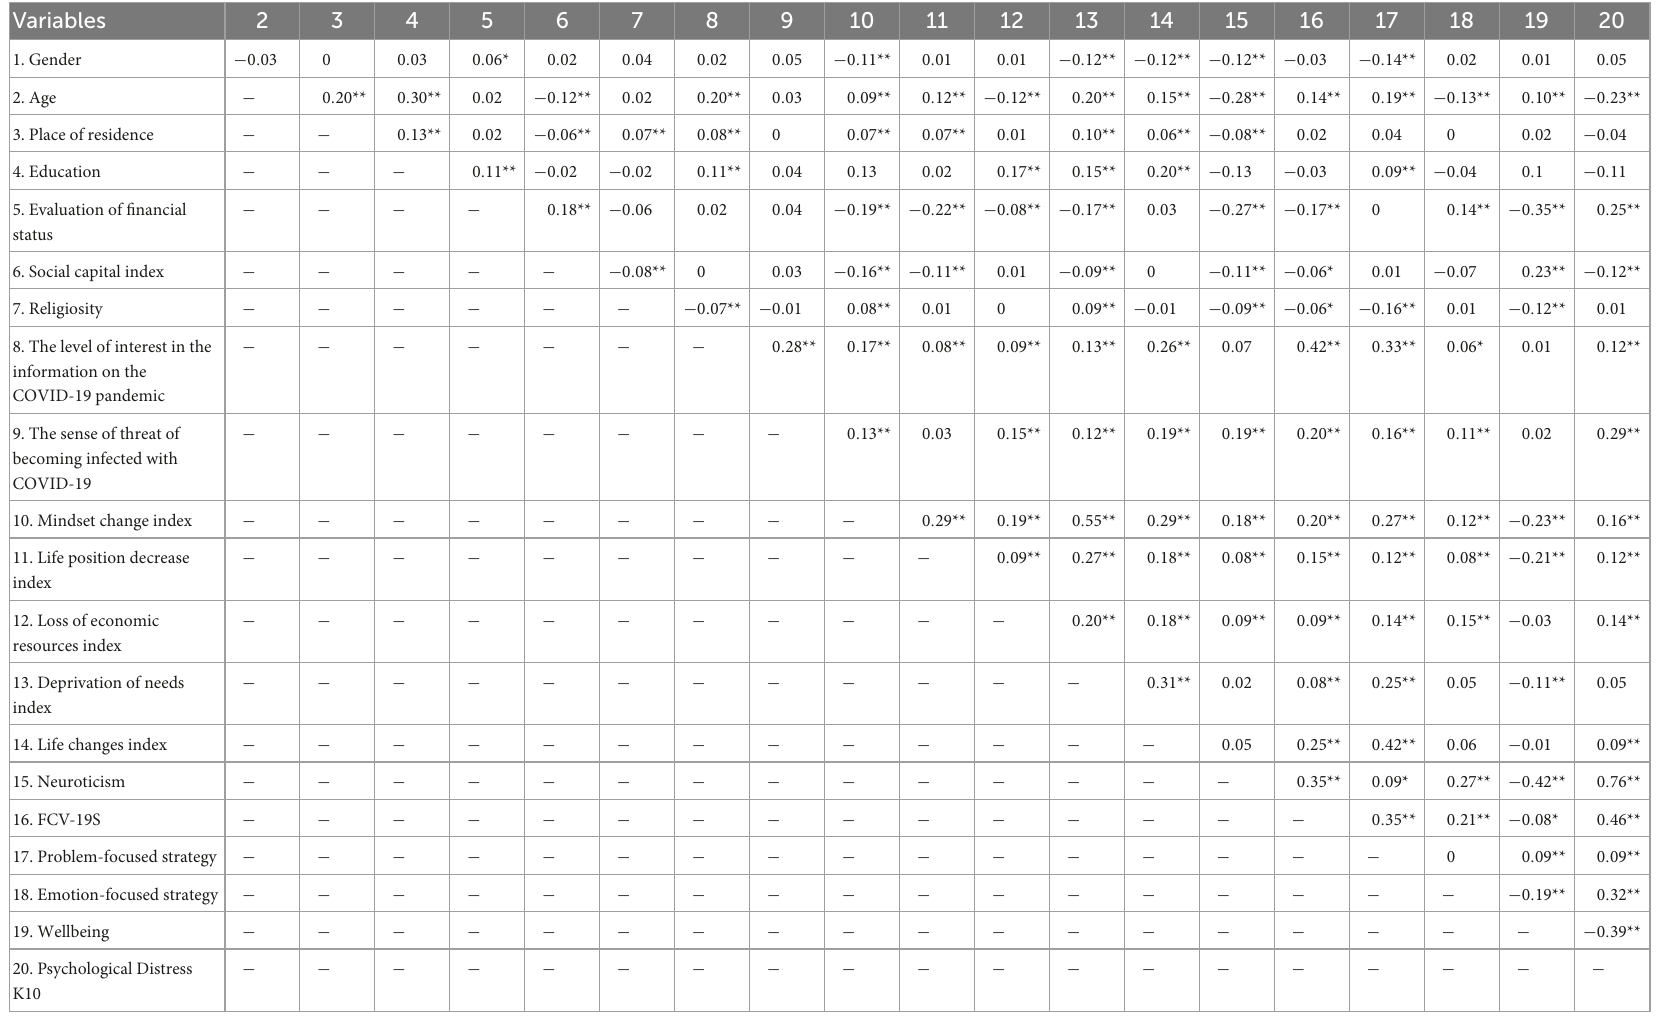
TABLE 6 Correlation coefficients among all